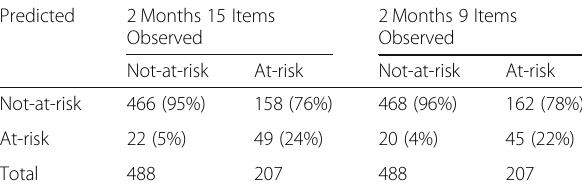
Table 6 Predicted and observed risk status at two months for 15- and nine-item versions based on linear discriminant analysis